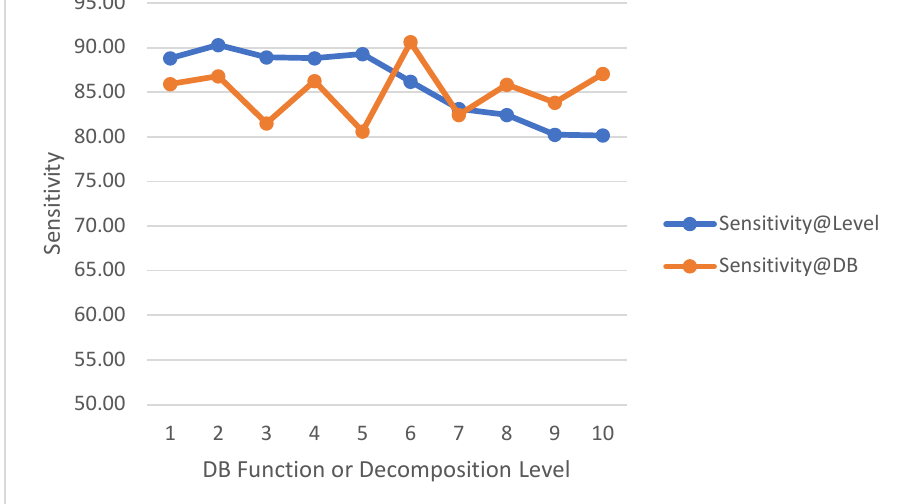
Table 7. Average specificity (%) due to DWBF and decomposition level (DL).